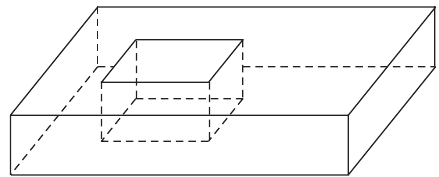
Figure 1: Sketch map of the mold with an insert in.